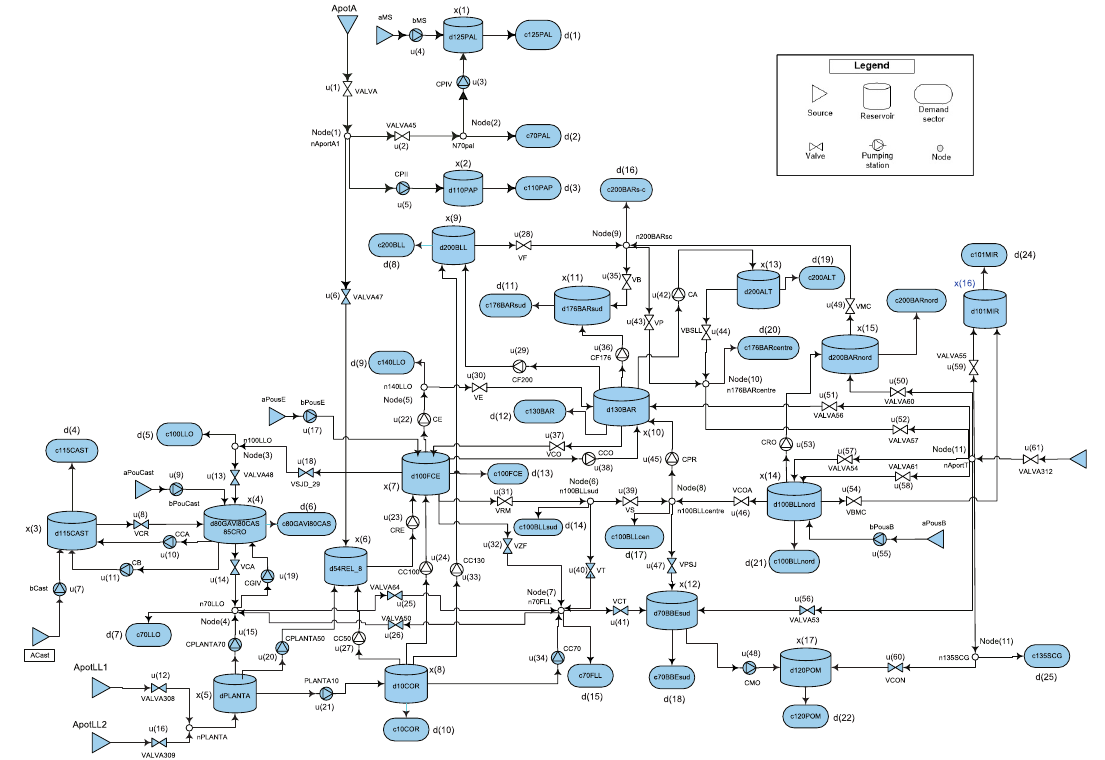
Figure 5. Barcelona drinking water